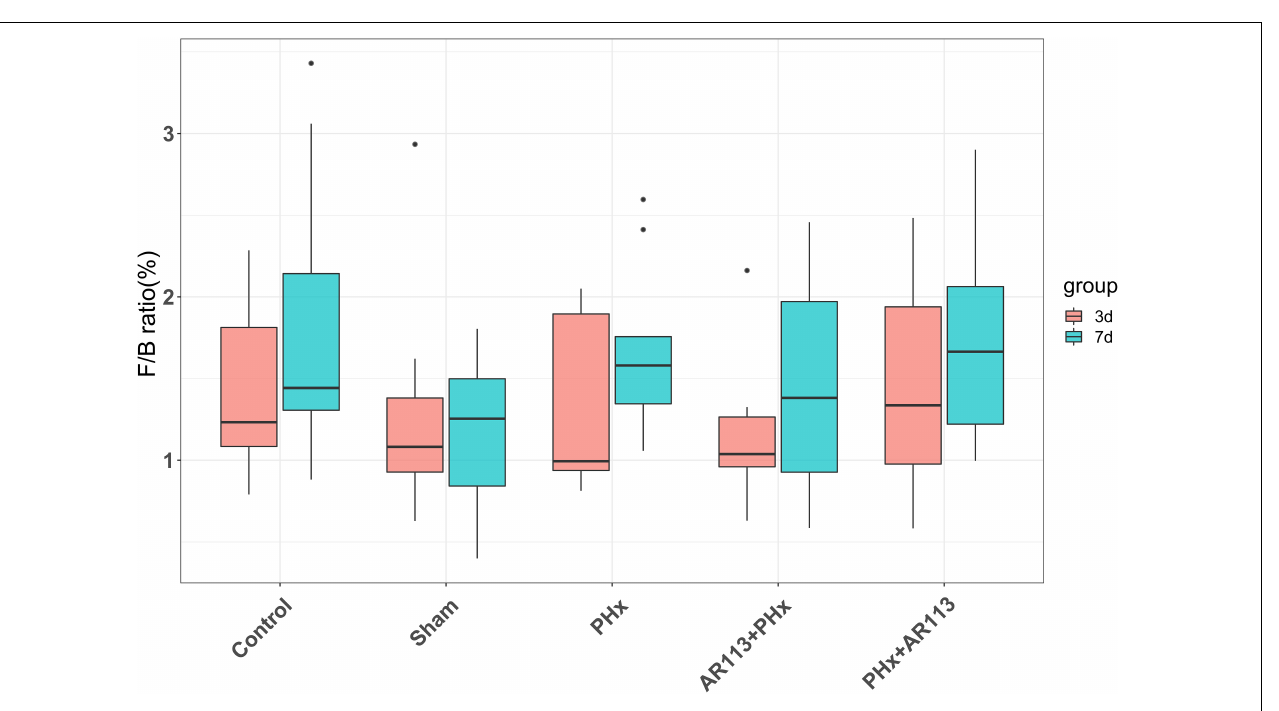
Thermotunica , Roseiarcus , Vagococcus , and Ruminiclostridium_5